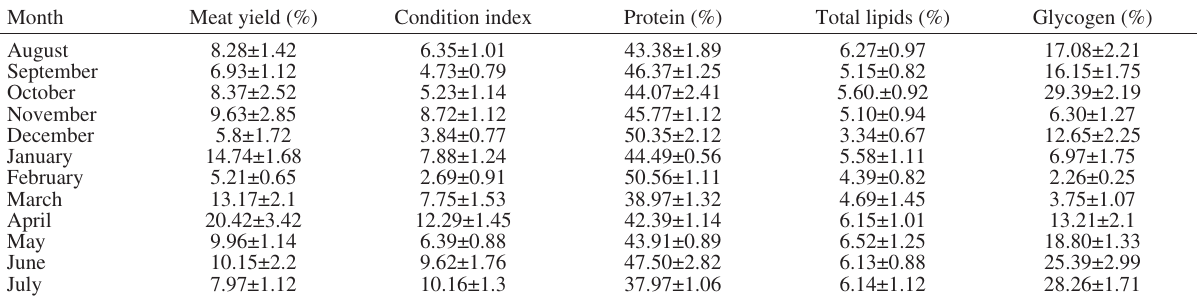
Table 1. – Monthly variation (mean±SD) meat yield, condition index, protein, total lipids, and glycogen in Ostrea edulis from August 2008 to July 2009. Month Meat yield (%) Condition index Protein (%) Total lipids